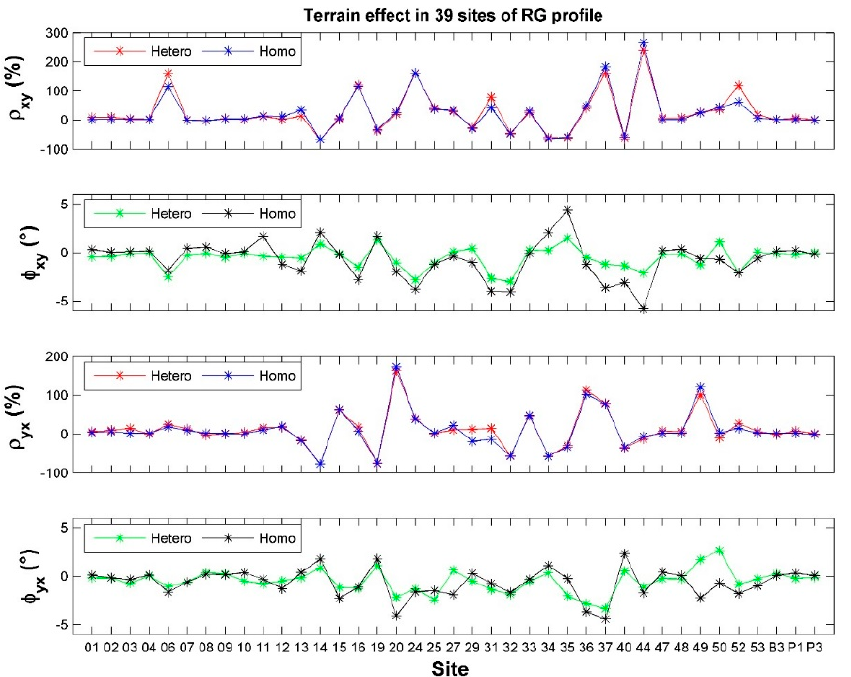
Figure 7. Comparison of the terrain effect in off-diagonal components by homogeneous half-space modeling and heterogeneous modeling (9-block model) in 39 sites of the RG profile. Site 06 is located at an altitude of 519 m, and the maximum variation in the elevation is along the N 43° W direction; the elevation varies from 507 m to 698 m, with the slope ranging between − 35° and +13° within 1 km from this site. Topographic elevations along the NS and EW directions around this site are shown in Figure 8b. The site is located on a valley slope. Therefore, the topographic effect of both slope and valley contributed to the results. However, the dominant topographic effects in off diagonal components are mainly due to the valley and are shown in Figure 8d,e for the homogeneous and hetero- geneous models, respectively. Topographic effects show different magnitudes of positive shifts in amplitudes of both (TE and TM) modes of polarization. In the literature, this is also referred to as static shift effect, which is mainly due to the accumulation of electrical charges at the interfaces of different electrical resistivity zones.